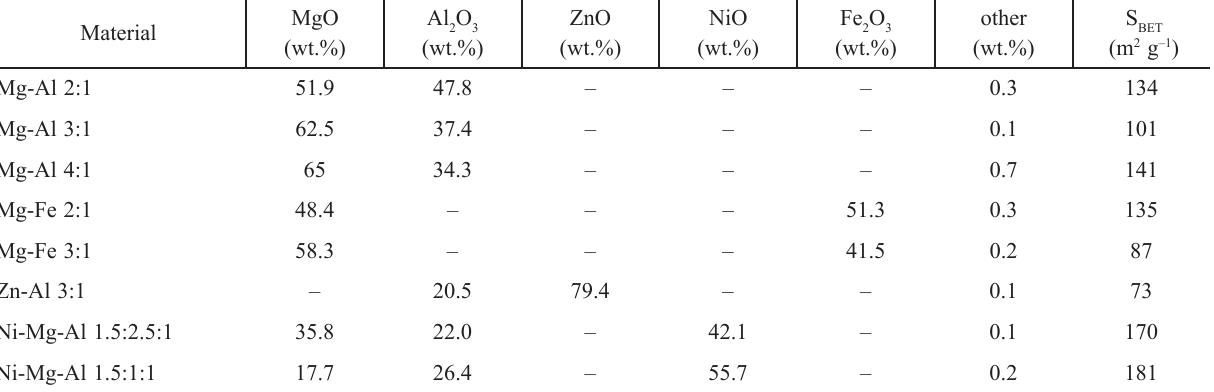
Table 1 – Composition (X-ray fluorescence) and specific surface area of prepared materials